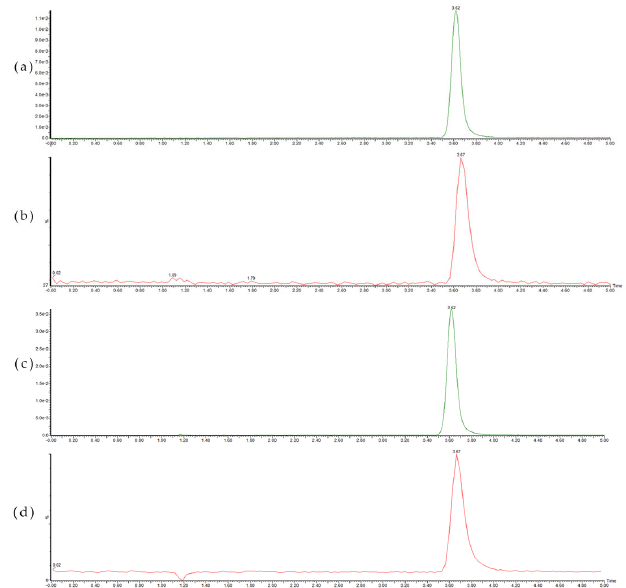
Figure 4. UPLC chromatograms (368 nm) of AA ‐ API ( a ) and the visible foreign solids ( c ), LC ‐ MS total ion current (TIC) of AA ‐ API ( b ) and the visible foreign solids ( d ).